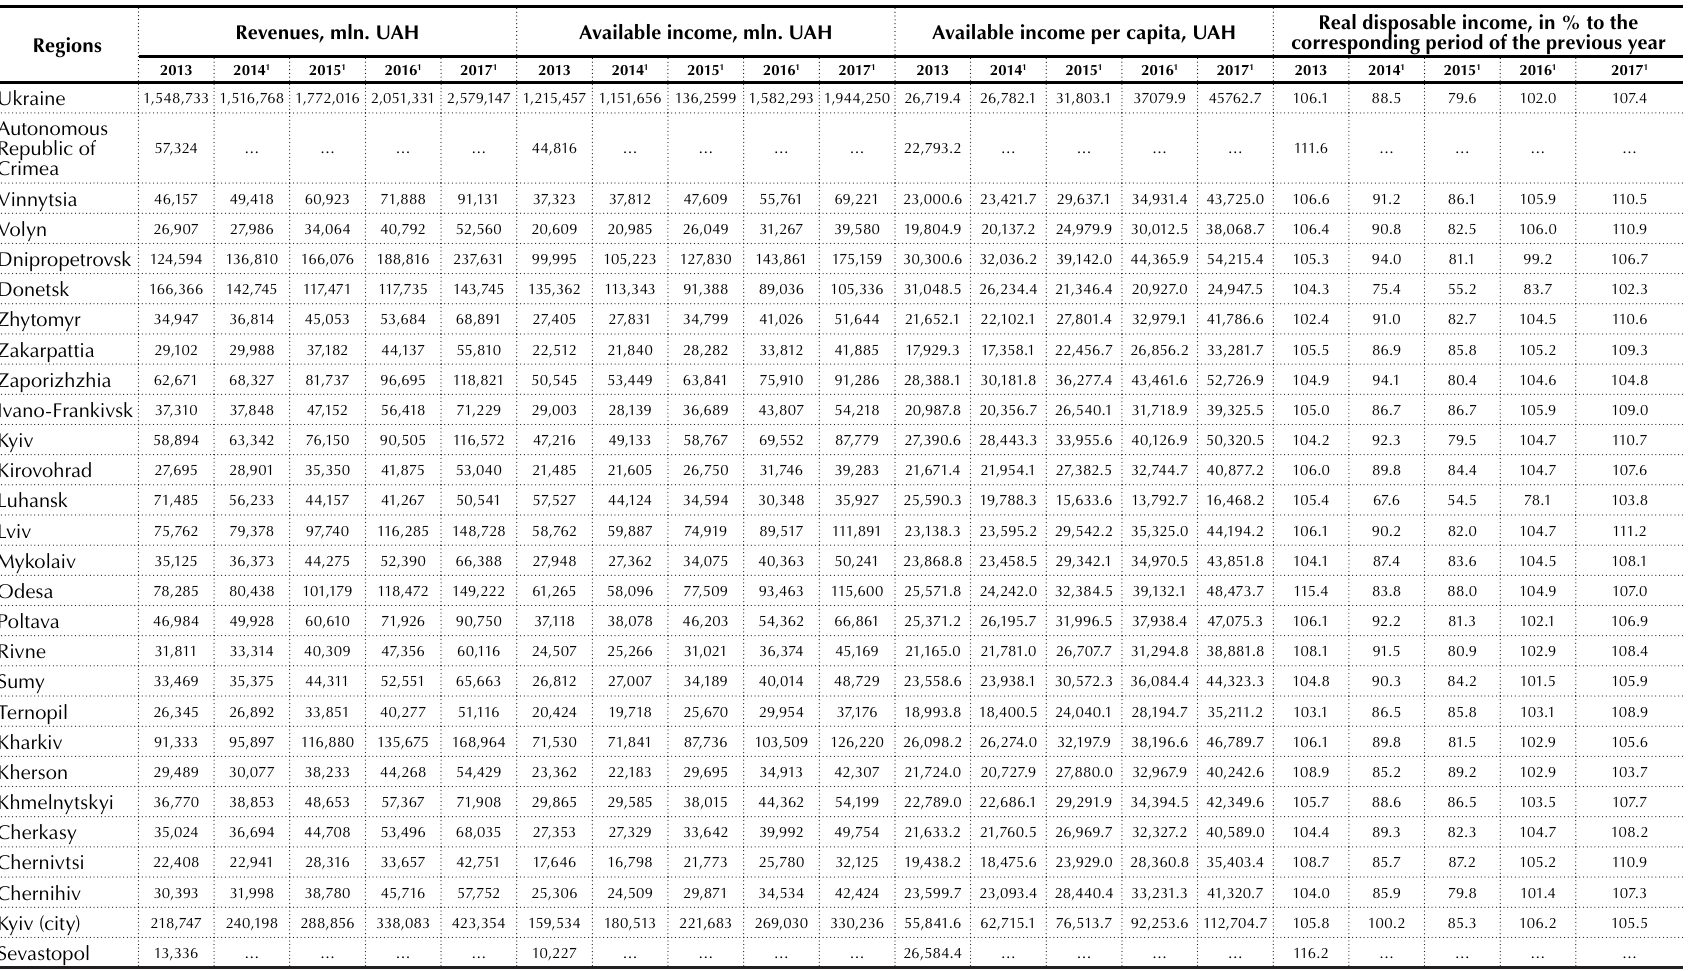
Source: Державна служба статистики України [Derzhavna sluzhba statystyky Ukrainy] (n.d.). Real disposable income, in % to the corresponding period of the previous